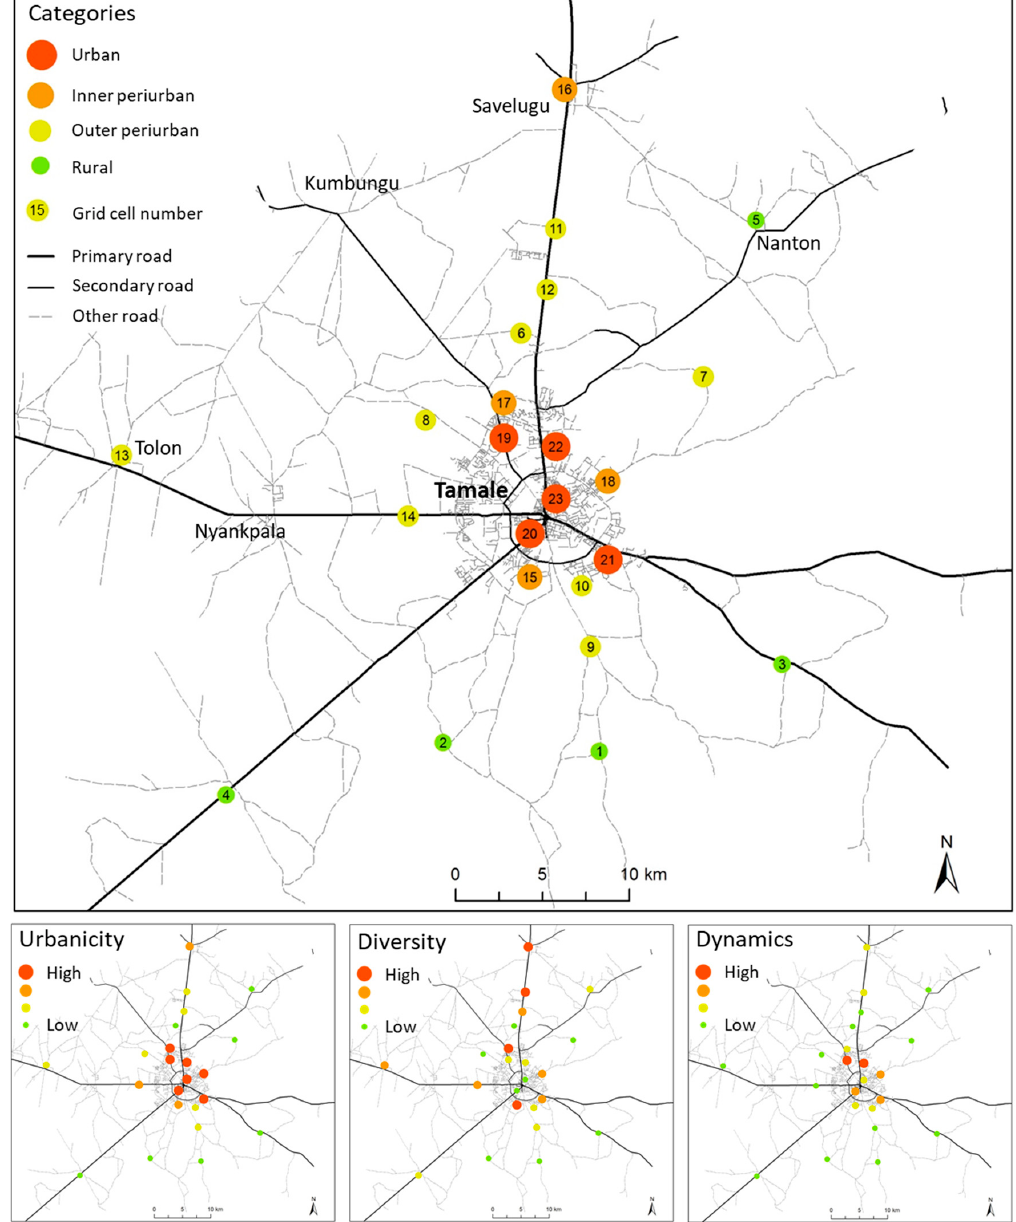
Figure 6. Map depicting urbanicity, diversity and dynamics values per sample grid cell and the assignment of land classification categories. Note: For the maps illustrating urbanicity, diversity and dynamics, values were divided into equal intervals and classified accordingly.